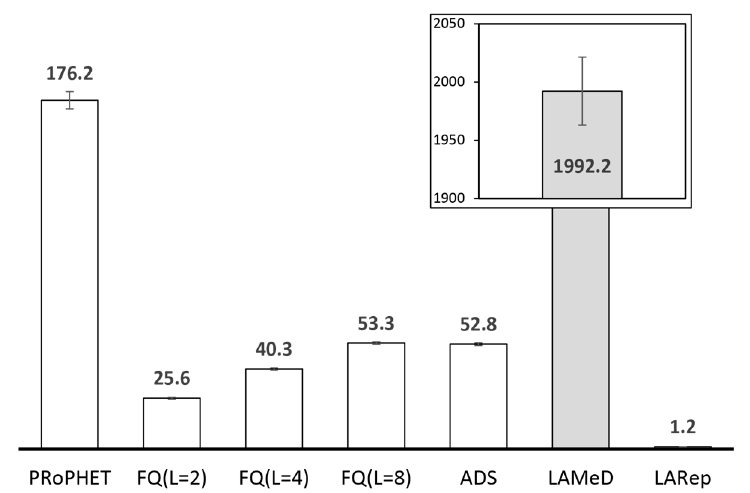
Figure 16. Average energy consumption (in Joules) in the Skudai scenario.